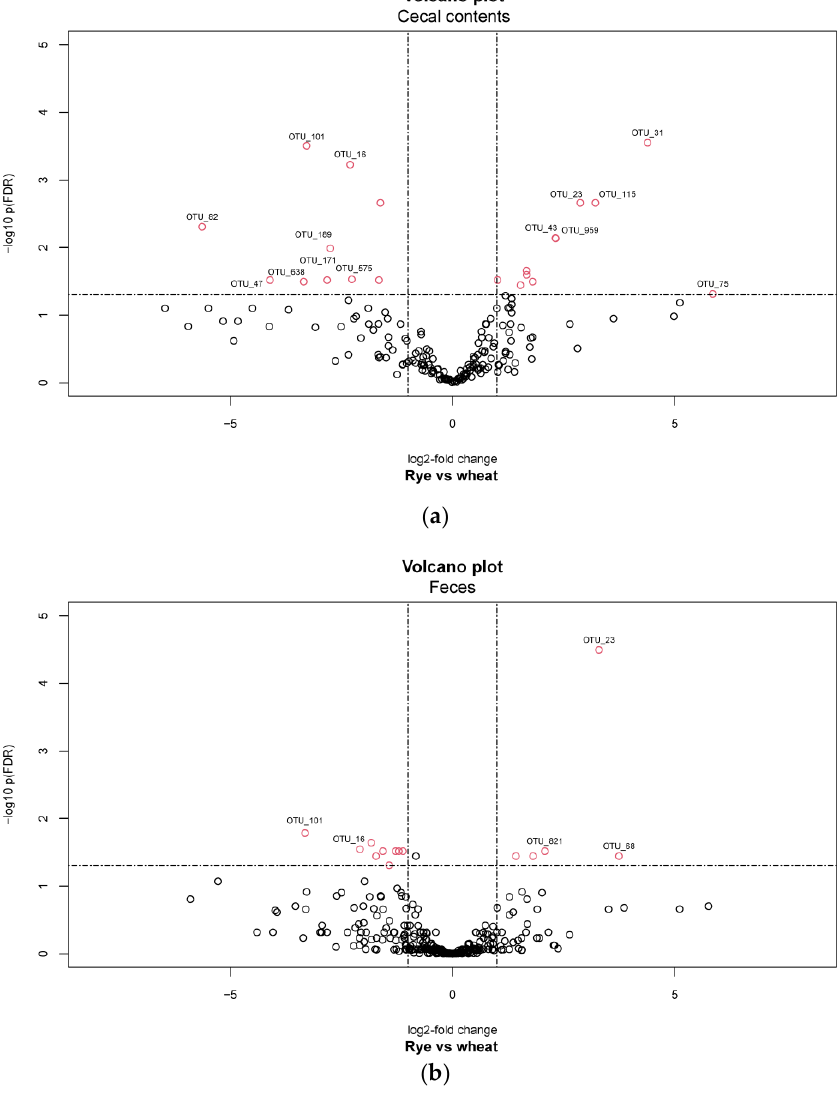
Figure 4. Volcano plot visualizing – log10 FDR-adjusted P -values versus log2-fold changes for all 319 OTUs. The horizontal lines show significance threshold for FDR < 0.05. Each open point represents a single OTU in: ( a ) cecal contents and ( b ) feces. Open points above the significance threshold and beyond the log2-fold change criterion of ±1 are indicated in red, while OTU names are labeled beyond the log2-fold change criterion of ±2.